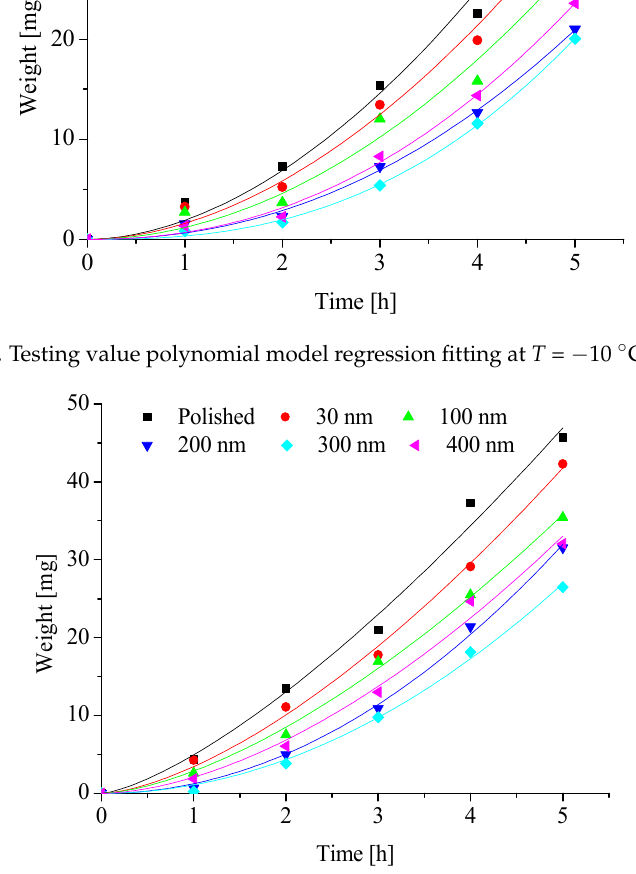
Figure 24. Testing value exponential model regression fitting at T = − 15 °C, φ = 60%.